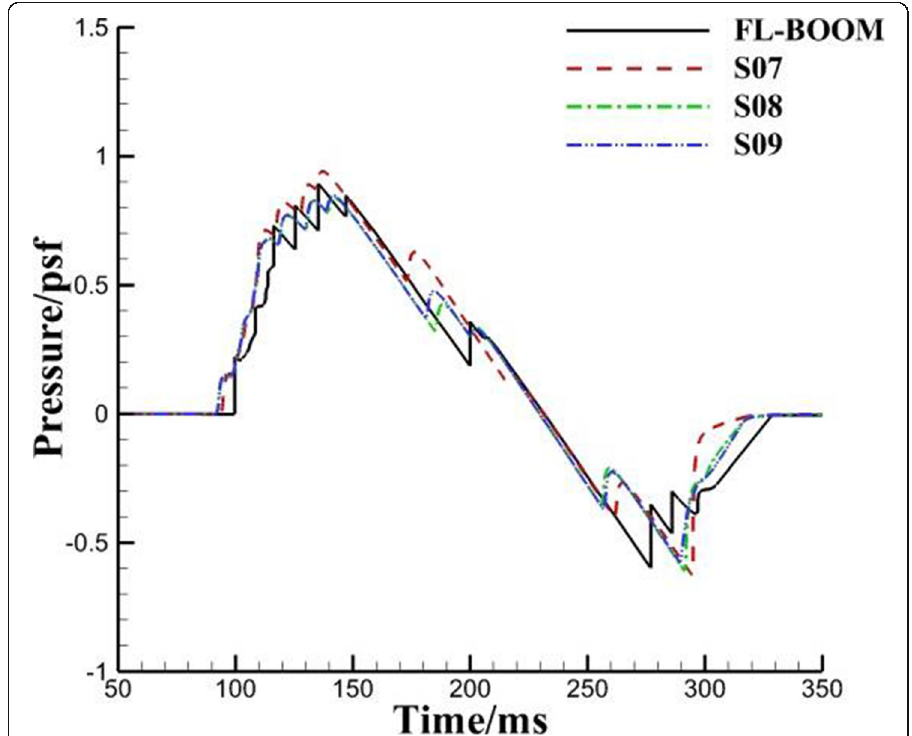
Fig. 4 Results of FL-BOOM VS. workshop